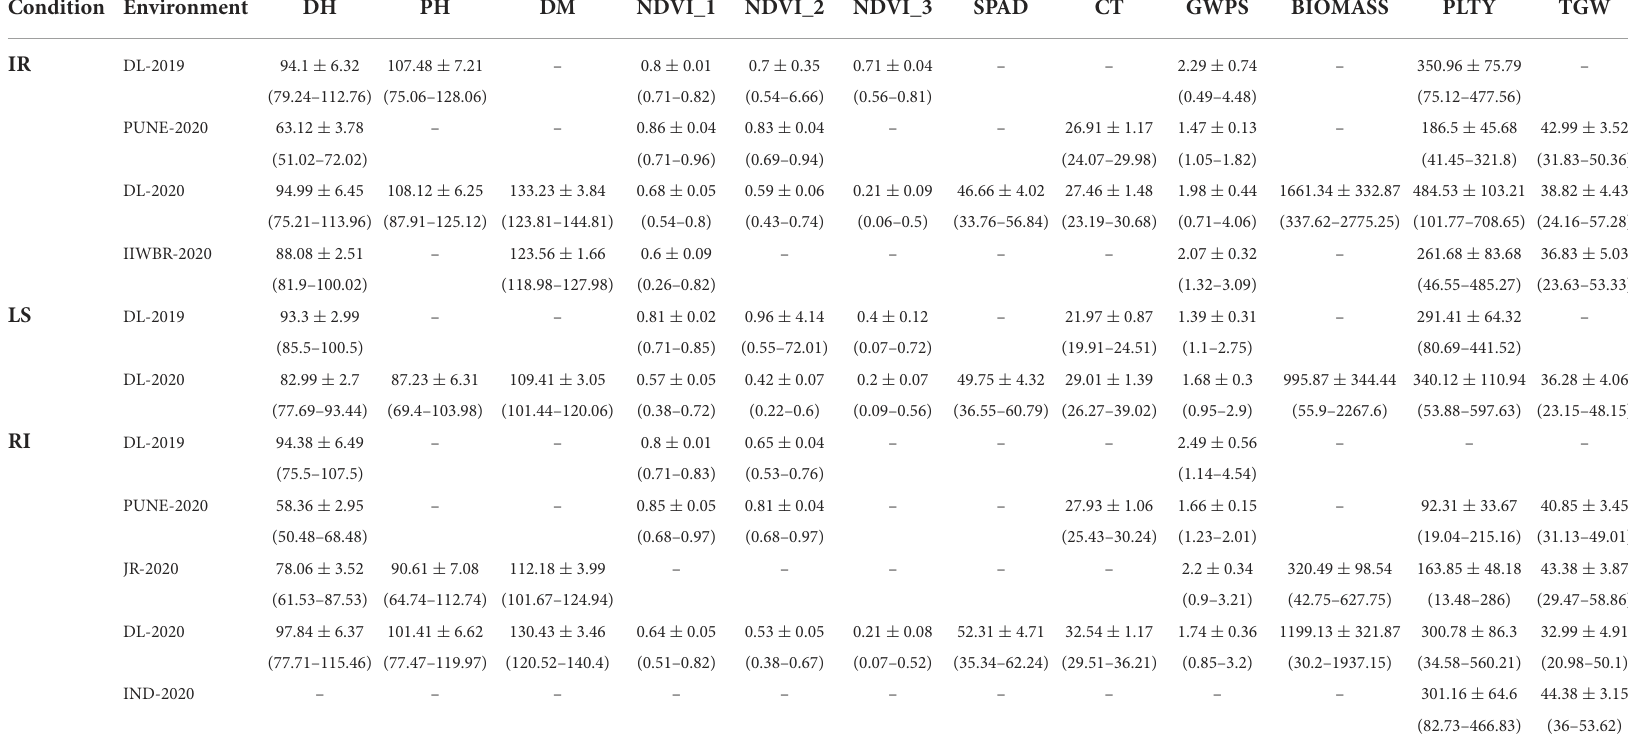
TABLE 2 A summary of yield and stress related traits in GWAS panel evaluated across the different environment. Condition